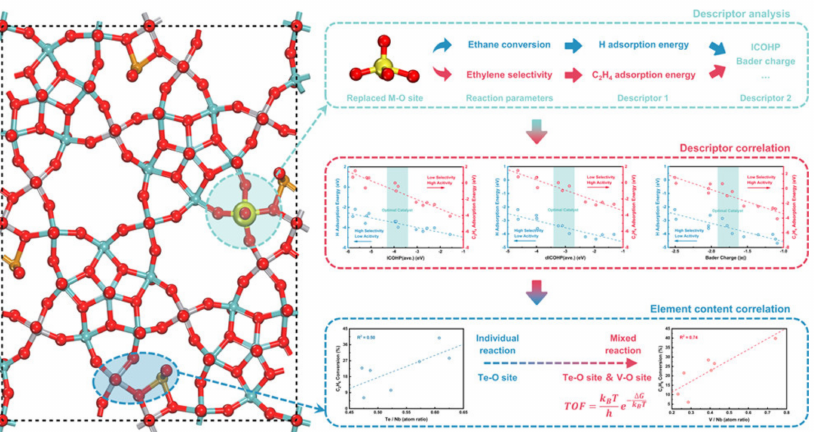
Figure 13. The influence of the introduction of different elements in the Mo-V M1 structure in the oxidative dehydrogenation of ethane. Adapted from ref. [29], Copyright (2022), with permission from the American Chemical